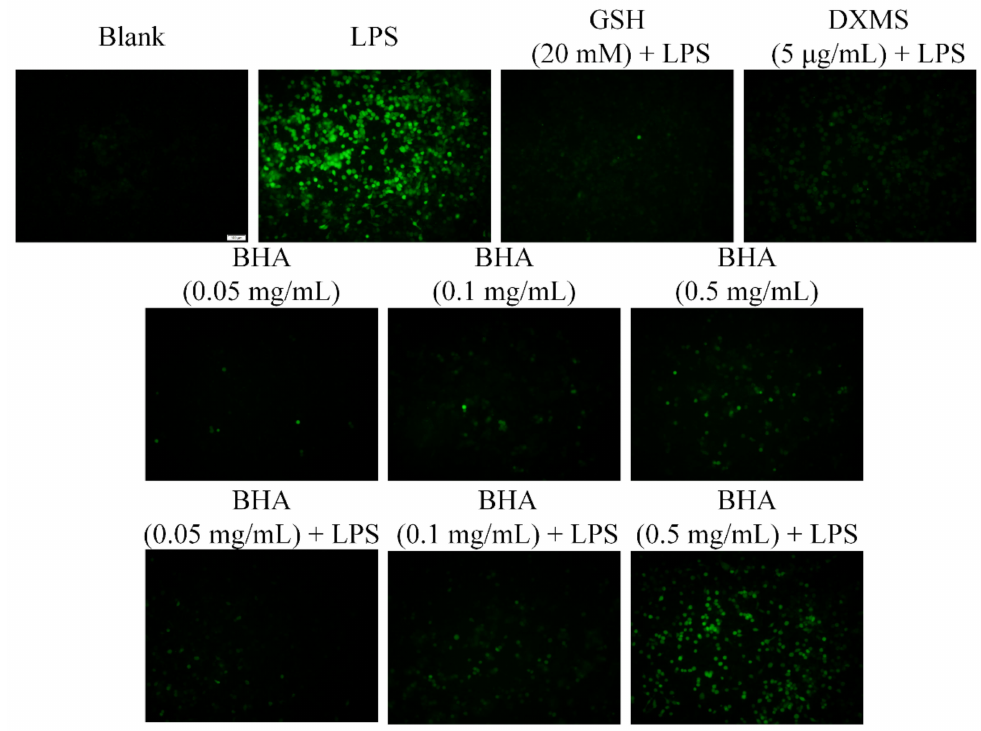
Figure 3. Evaluation of the antioxidant activity of BHA in LPS-induced RAW264.7 macrophages. Cells were treated with various concentrations of BHA for 12 h in the presence or absence of LPS (1 µ g/mL) for 12 h. The generation of ROS was measured and confirmed via DCFH-DA